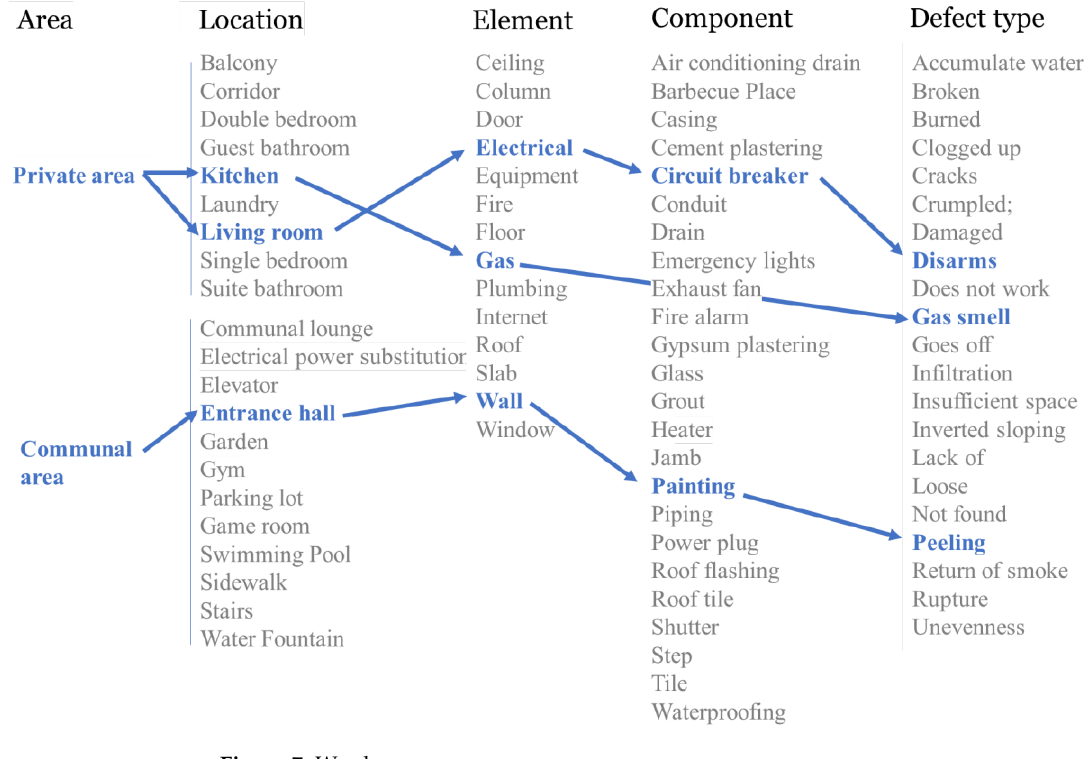
Figure 7. Word menu. Figure 7. Word